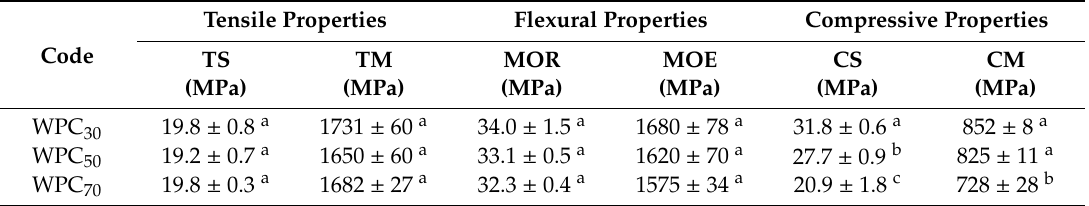
Table 4. Mechanical properties of FDM-printed WPC parts at various printing